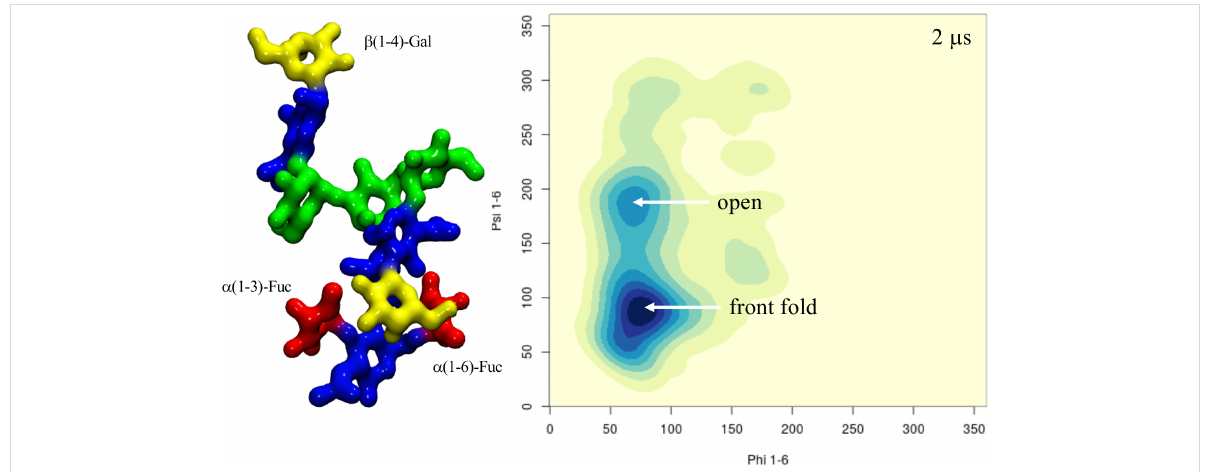
Figure 6: Conformational equilibrium of the (1-6) arm in terms of phi/psi torsion angle values for the α (1-3)-fucosylated FA2G2 N-glycoform. The structure with the folded (1-6) arm where the terminal β (1-4)-Gal interacts with both fucose residues is shown on the left-hand side. The N-glycans structures are shown with the (1-3) and (1-6) arms on the left and on the right, respectively. The monosaccharides colouring follows the SFNG nomenclature. The structure rendering was done with VMD (https://www.ks.uiuc.edu/Research/vmd/) and the graphical statistical analysis with RStudio